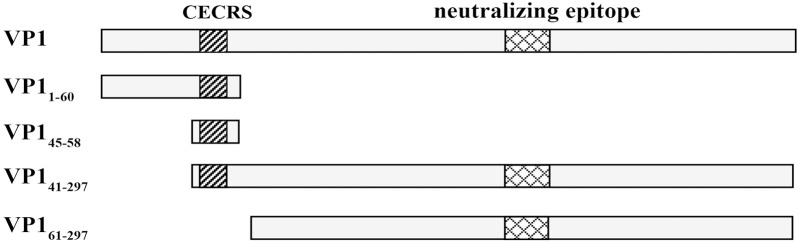
The design of the four truncated CA16 VP1 proteins.In the present study, four CECRS-based antigens VP11-297 (full antigen), VP11-60 (N antigen), VP145-58 (core antigen), VP141-297 (C antigen), and a control antigen (VP161-297) without the CECRS were designed and constructed.